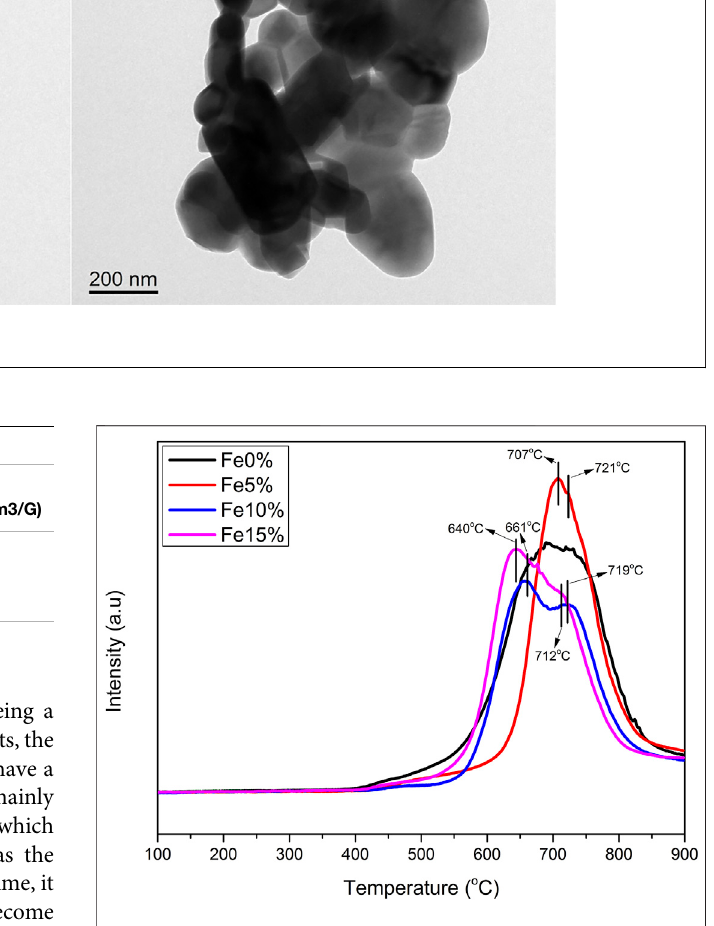
FIGURE 7 | H 2 -TPR